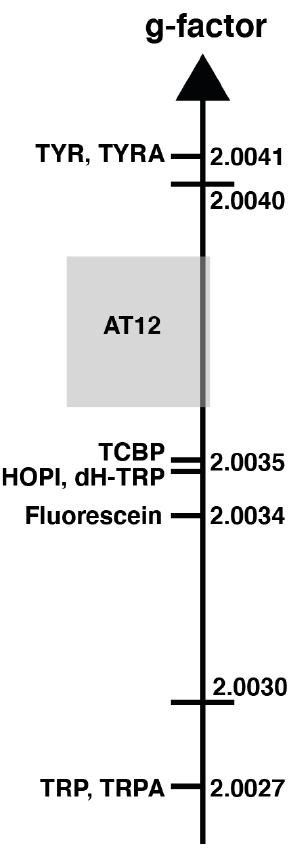
Figure 2. The sign alternation enables us to locate the molecules on the g -value scale. The ranking of HOPI and dH-TRP provides fine-scale information about their radical g values. For the abbre- viations that are not defined elsewhere, TRP stands for tryptophan, TRPA stands for tryptamine, TYR is tyrosine and TYRA is tyra- mine. (Figure was adapted from Sobol et al.,